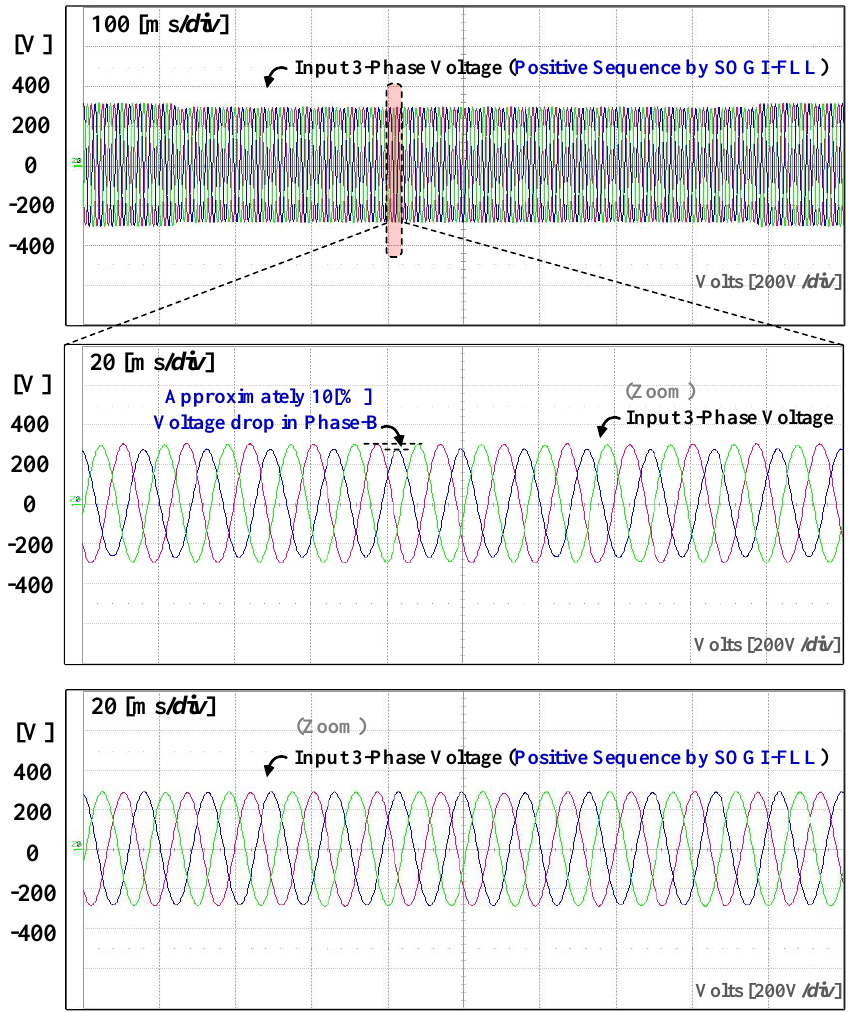
Figure 28. Waveforms of extracted 3-phase positive sequence input voltage using SOGI-FLL when the b phase has voltage drop.